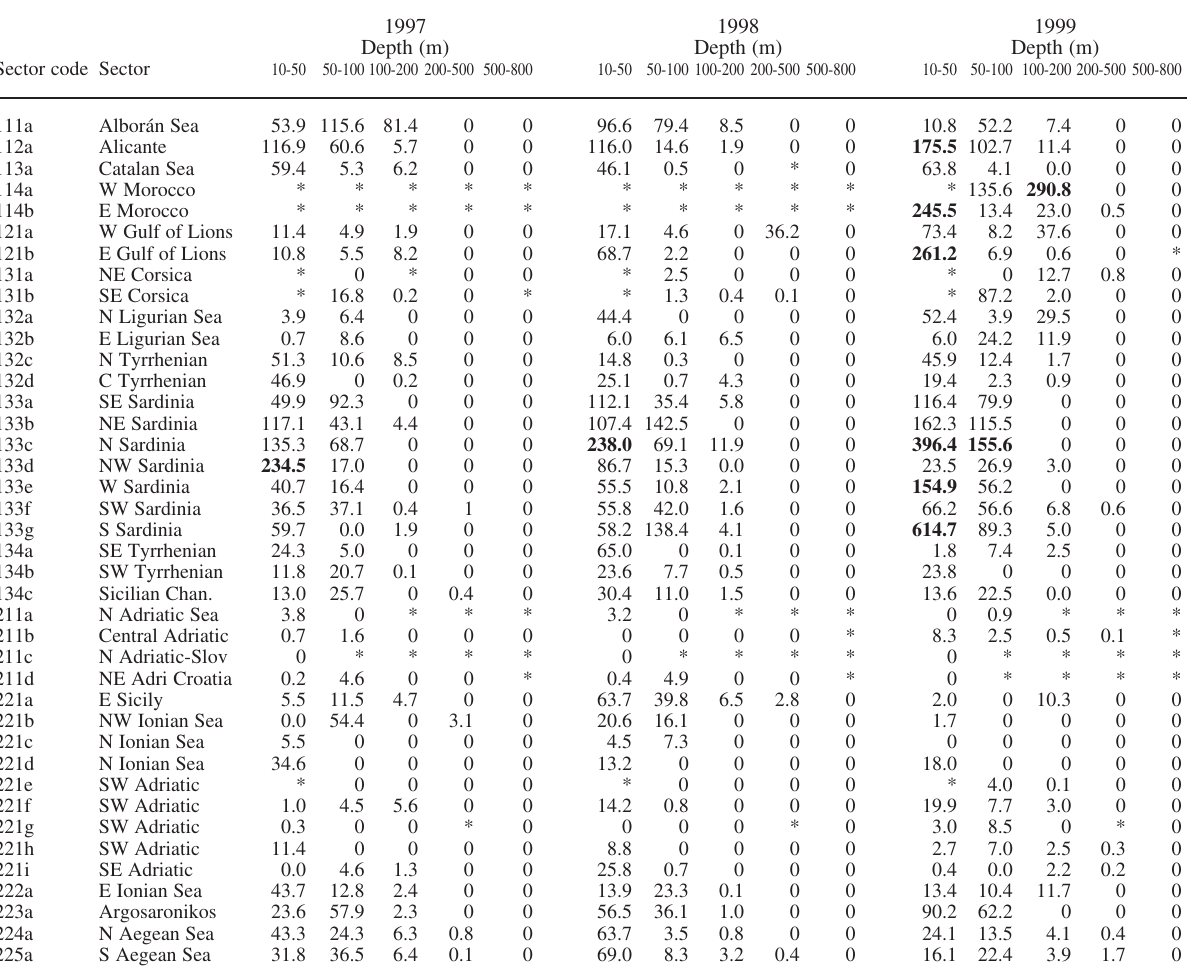
Table 3.- Octopus vulgaris : Mean biomass (kg/km 2 ) estimated from the MEDITS trawl surveys by depth stratum, geographical sector and year (1994-1999). Not sampled strata are indicated by ‘*’. Values higher than 150 kg/km 2 are presented in